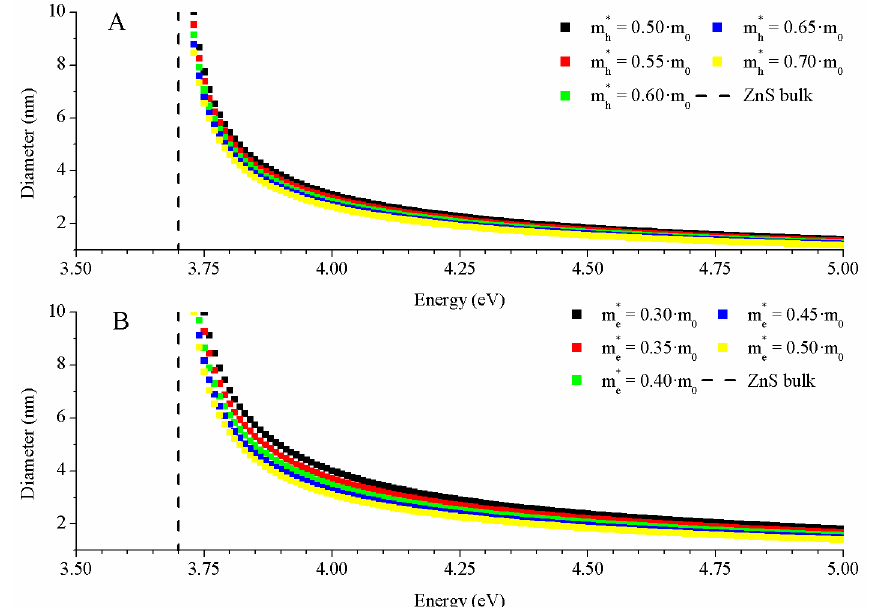
Figure 11. Estimated ZnS NPs’ size by HBM model as a function of nanoparticle bandgap energy with ( A ) m h * and m e * ( B ) as parameters. The m h * oscillated between m h * = 0.50 · m o and m h * = 0.70 · m o and m e * oscillated between m e * = 0.30 · m o and m h * = 0.50 · m o , with E b remaining constant, E b = 3.70 eV.